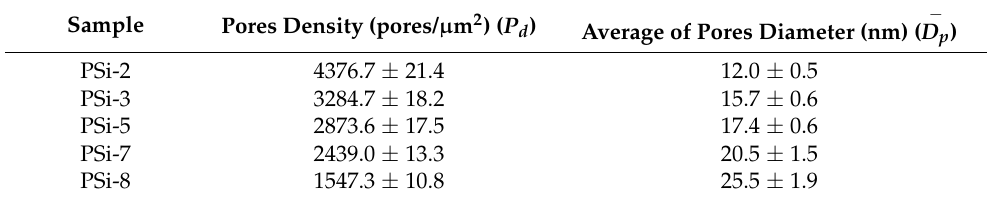
Table 2. Pore distribution analysis in